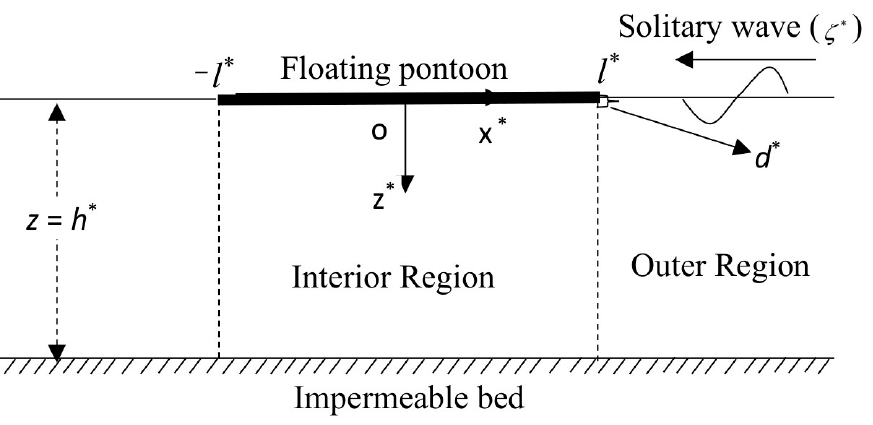
Figure 1. Schematic diagram: solitary wave interaction with a floating pontoon.